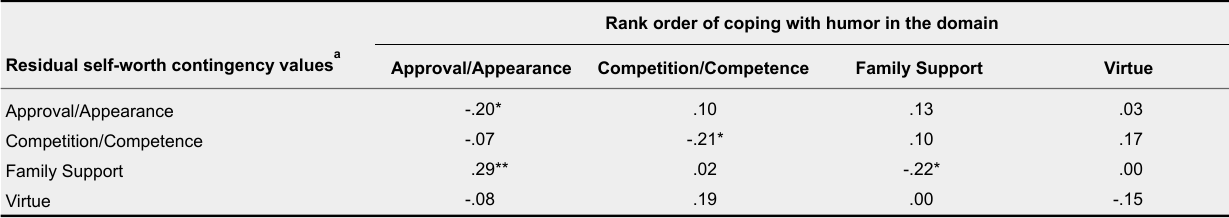
Spearmans Rho Between Rank Order of Coping With Humor and Residual Self-Worth Contingency Values Rank order of coping with humor in the